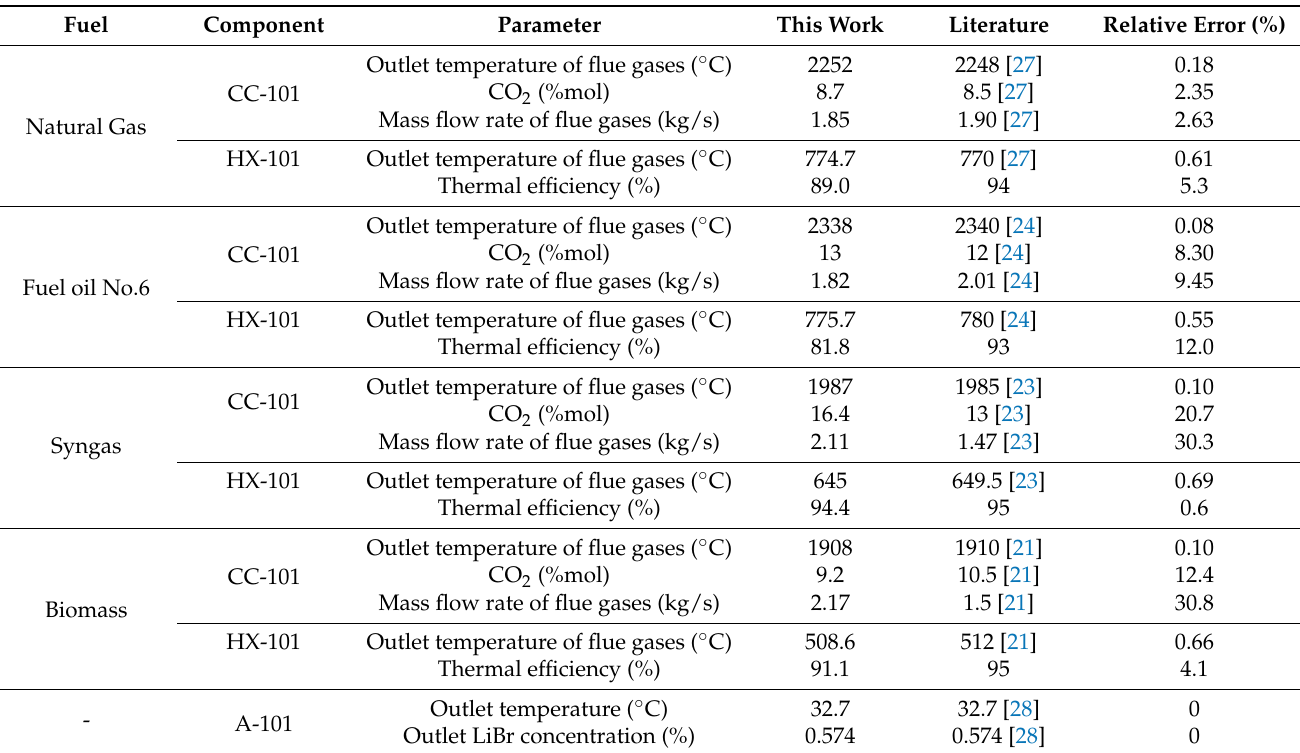
Table 7. Results of model